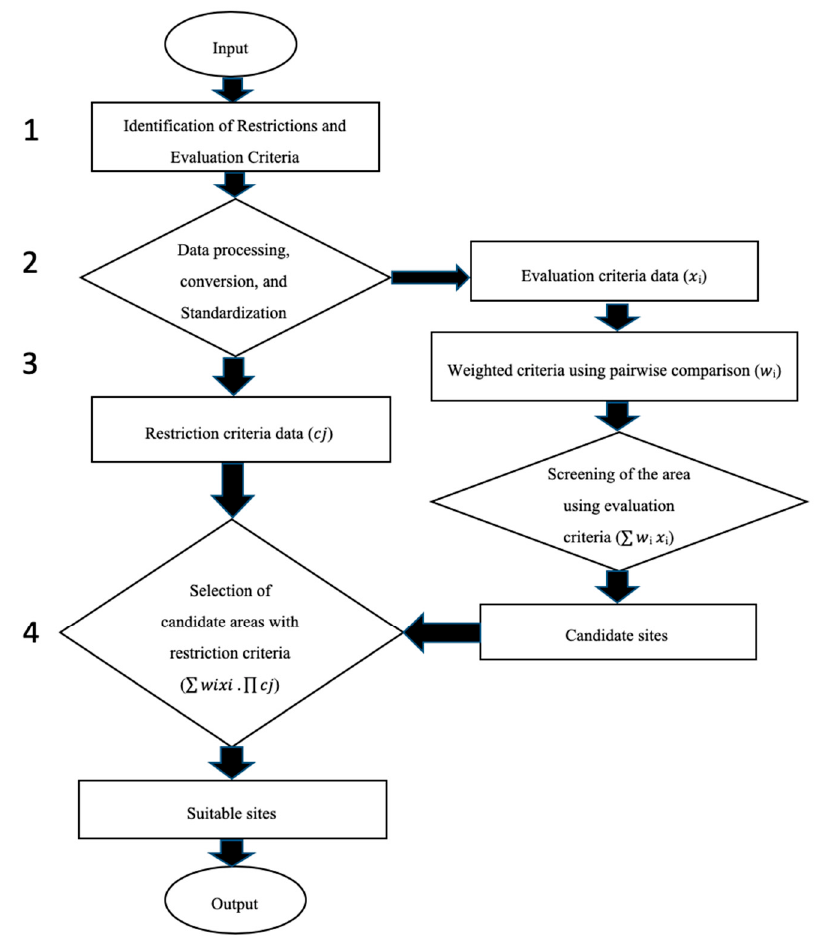
Figure 3. Study flowchart.